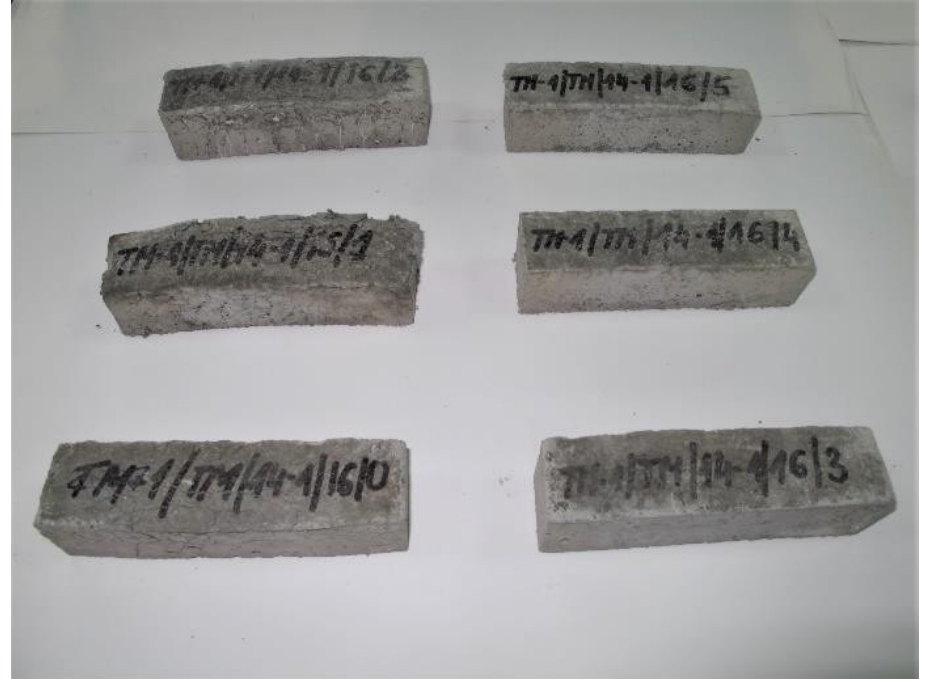
Figure 12. View of TM-1/TM/14-1 repair mortar samples after freeze-thaw cycles according to [19]. Visible deformation, cracks and weight loss of the samples, especially with the following designations: TM-1/TM/14-1/16/0, TM-1/TM/14-1/16/1 and TM-1/TM/14-1/16/2.